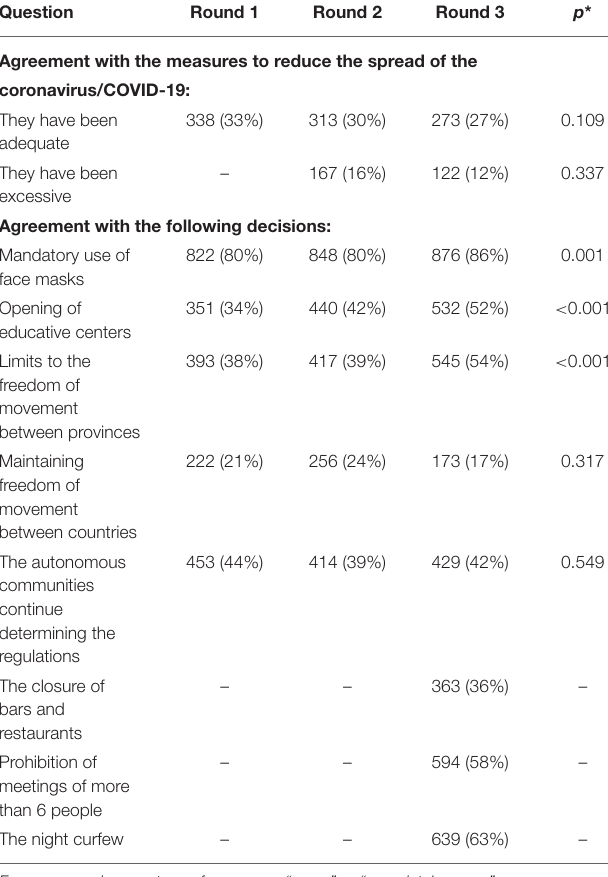
TABLE 2 | Knowledge on coronavirus/COVID-19 in each round. Question